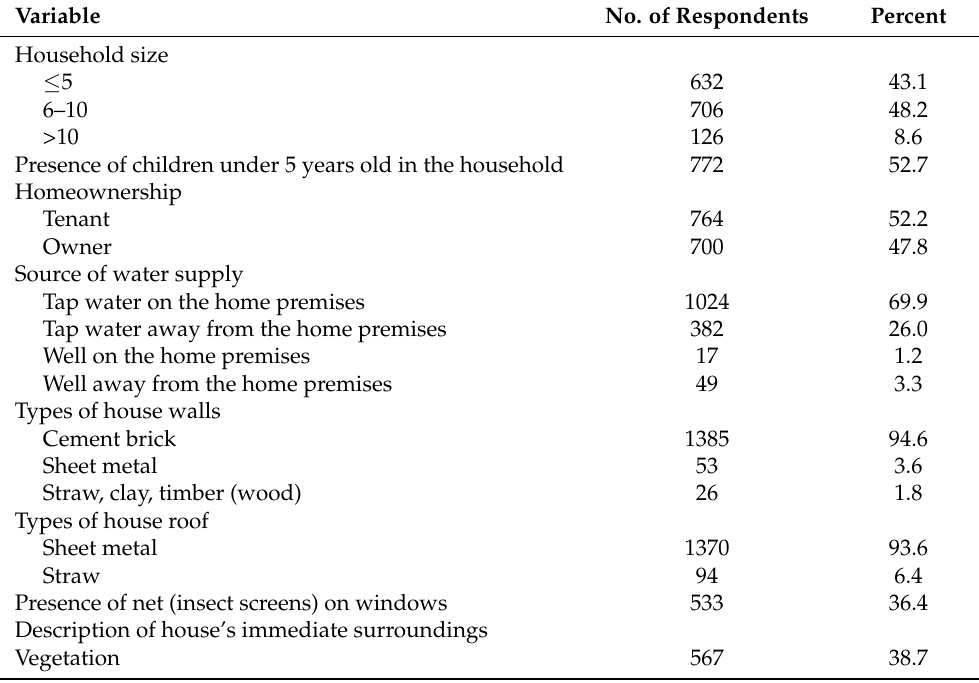
Table 2. Characteristics of participating households and their immediate